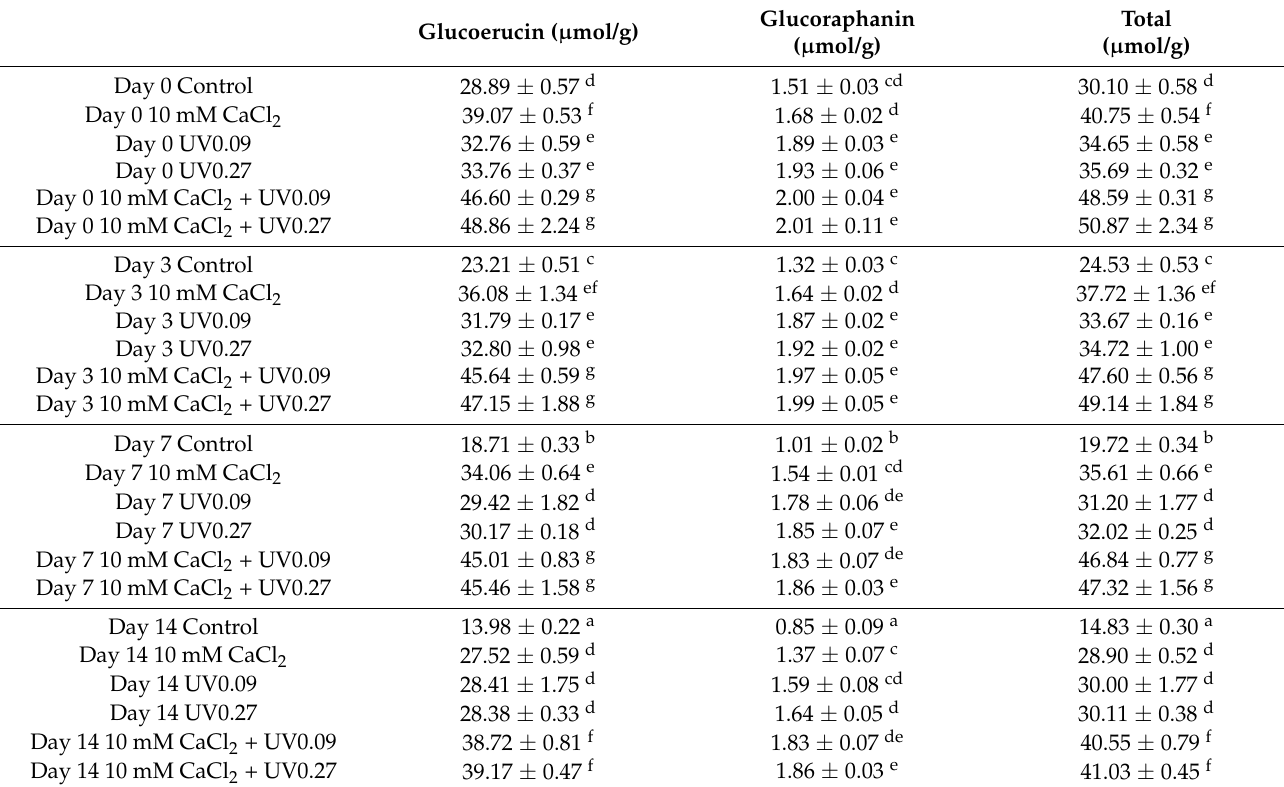
Table 1. Glucoraphanin, glucoerucin and total glucosinolate contents of preharvest UVB-treated broccoli microgreens during